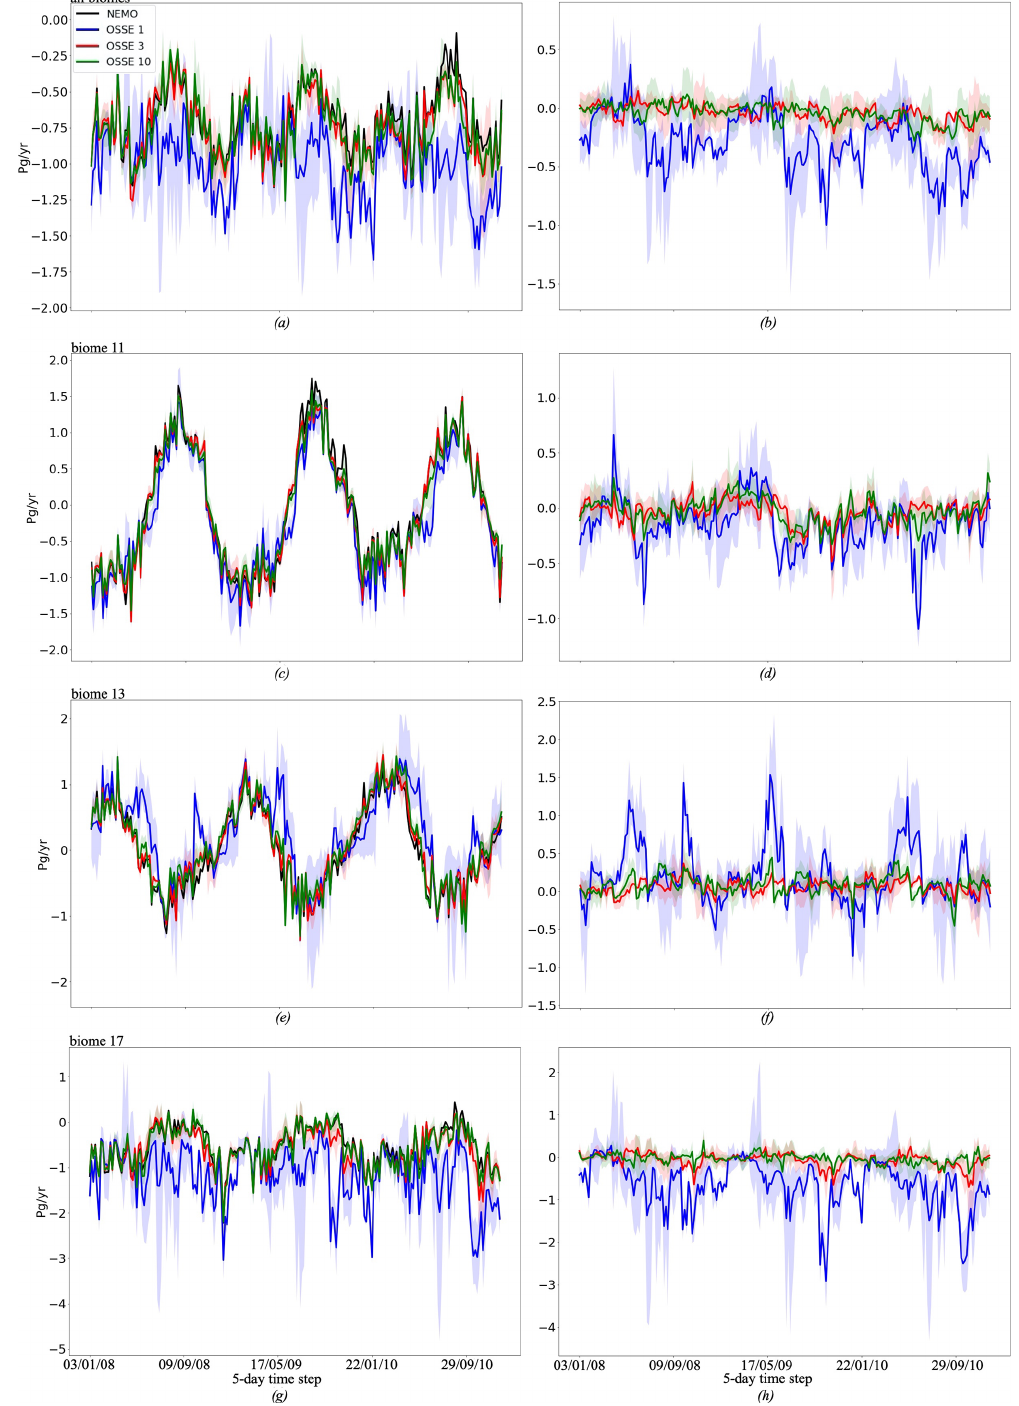
Figure 8. (a, c, e) Mean of fg CO 2 from four FFNN outputs for OSSE 1 (blue) (SOCAT data only), 3 (red) (SOCAT and synthetic Argo data) and 10 (green) (SOCAT data, 25% of the original synthetic Argo data in the Southern Hemisphere, and data from mooring stations); shading corresponds to the maximum and minimum values from four FFNN fg CO 2 estimates for each OSSE. The black curve shows NEMO/PISCES fg CO 2 . (b, d, f) Mean of differences of four FFNN outputs between OSSE 1 (blue), 3 (red), and 10 (green) fg CO 2 and NEMO/PISCES fg CO 2 ; shading corresponds to the maximum and minimum values of differences from four FFNN fg CO 2 for each OSSE. (a, b) Estimates are available for all biomes presented in Fig. 2, except biome 8: (c, d) biome 11 (subtropical permanently stratified North Atlantic), (e, f) biome 13 (subtropical permanently stratified South Atlantic), and (g, h) biome 17 (Southern Ocean